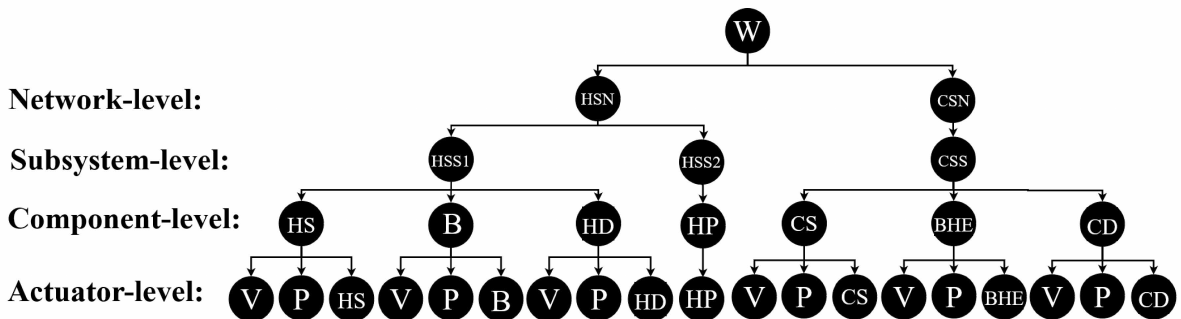
Figure 6. Hierarchical structure of the energy system after decomposition. W: whole system; HSN: heat supply network; CSN: cold supply network; HSS: Heat supply subsystem; CSS: cold supply subsystem; HP: heat pump; HS: Heat storage; B: Boiler; HD: heat demand; CD: cold demand; V: valve; P: pump; BHE: borehole-heat-exchanger field; CS: cold